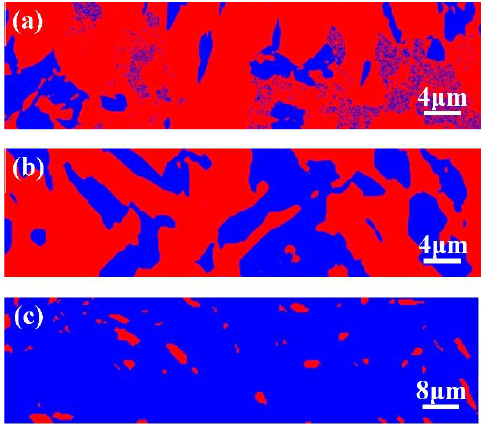
Figure 9. EBSD phases distribution of joint: ( a ) SZ-top; ( b ) SZ-bottom and ( c ) BM. Red represents austenite phase and blue represents martensitic